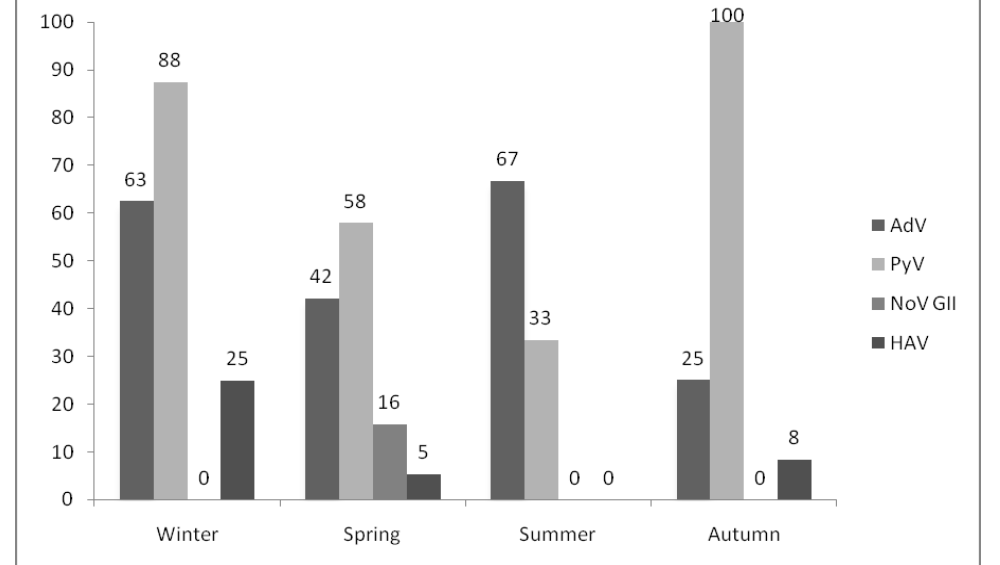
Figure 2. Seasonal percentage (%) detection of viruses in the forty-eight (48) analyzed sewage samples. AdV: adenoviruses, PyV: polyomaviruses, NoV GII: noroviruses, HAV: hepatitis A